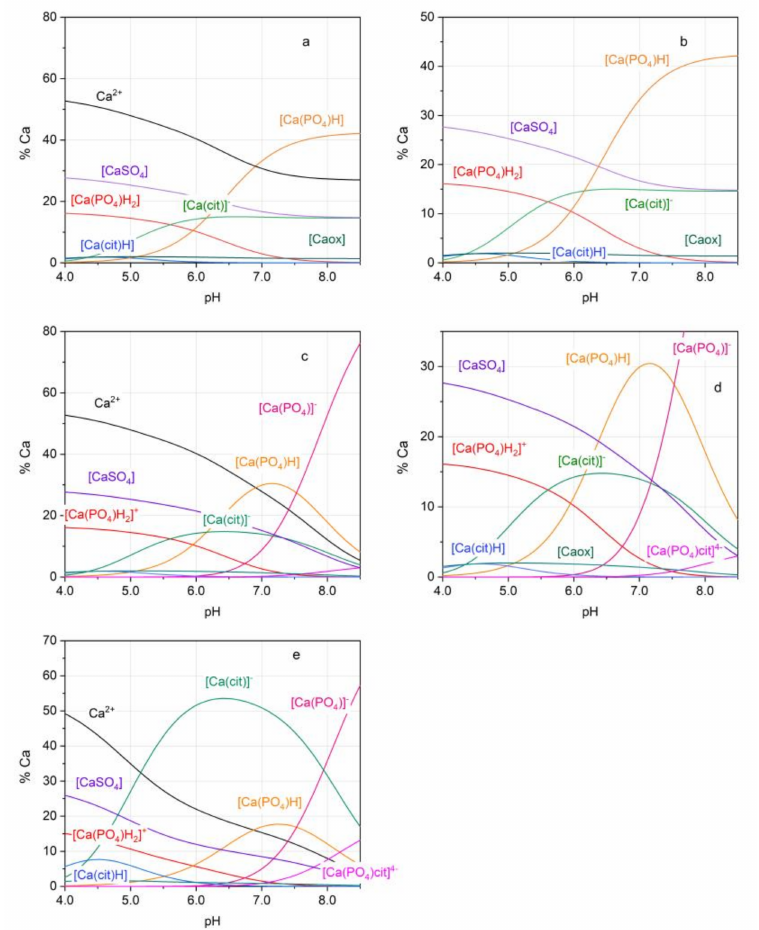
Figure 3. Speciation plots for the urine B obtained with Model 1: ( a ) full figure; ( b ) zoomed figure; and with Model 2: ( c ) full figure; ( d ) zoomed figure. ( e ) Speciation plots for urine B, obtained with Model 2 upon increasing total concentration of citrate to 4.0 × 10 − 3 mol L − 1 ; cit = citrate anion; ox = oxalate